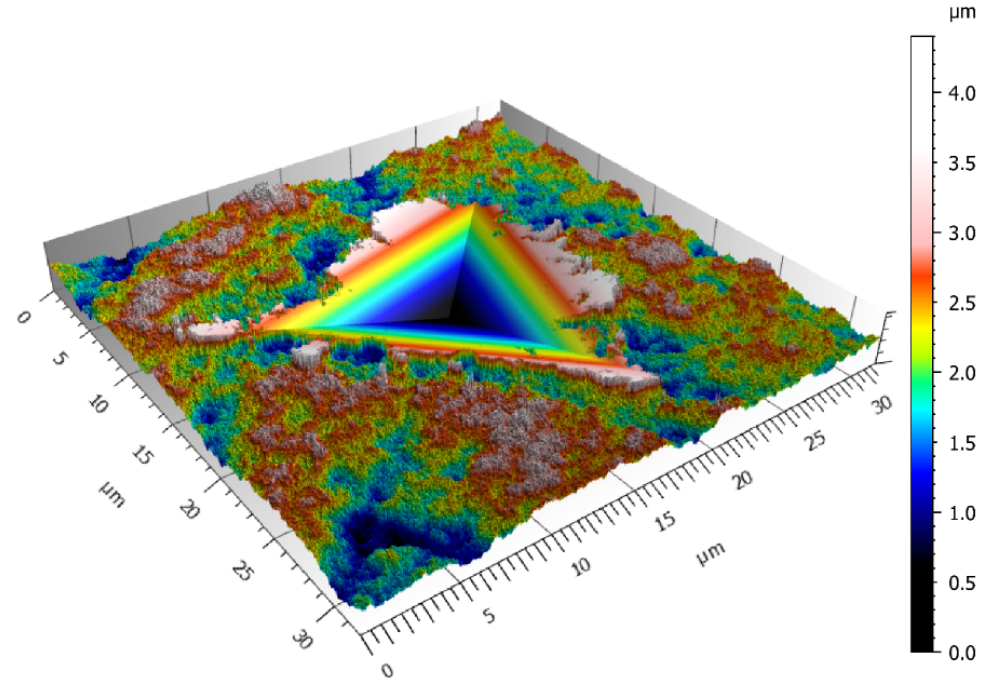
Figure 2. Example of the indentation of a Weierstrass surface with a S q of 0.5 µm, a fractal dimension of 2.5, and no-high-pass filtering. The indenter is not shown but is still in contact with the surface.